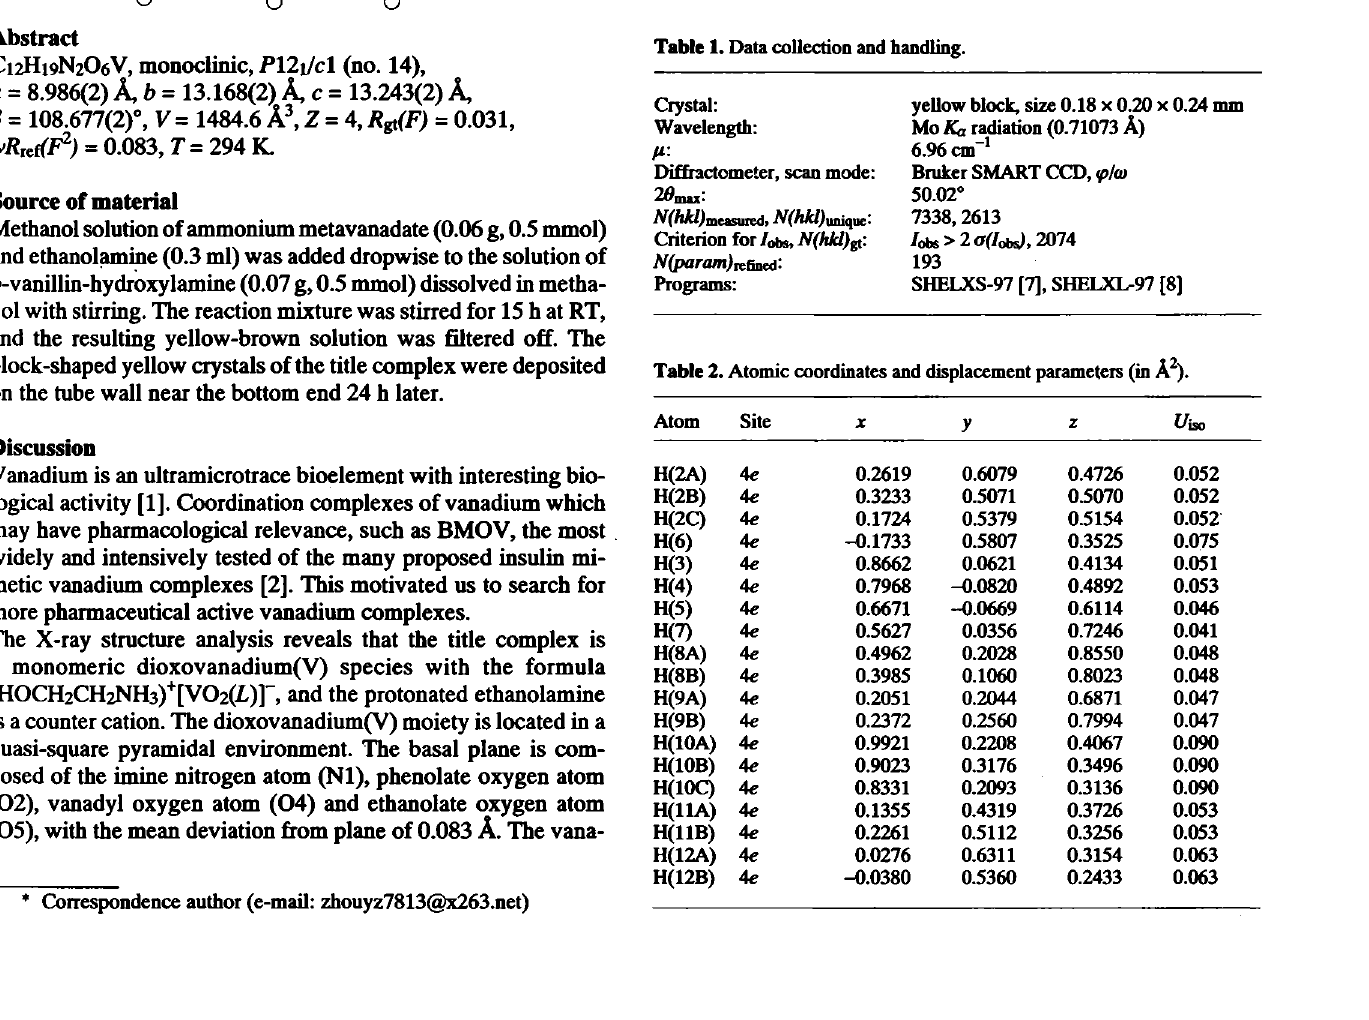
Table 1. Data collection and handling.